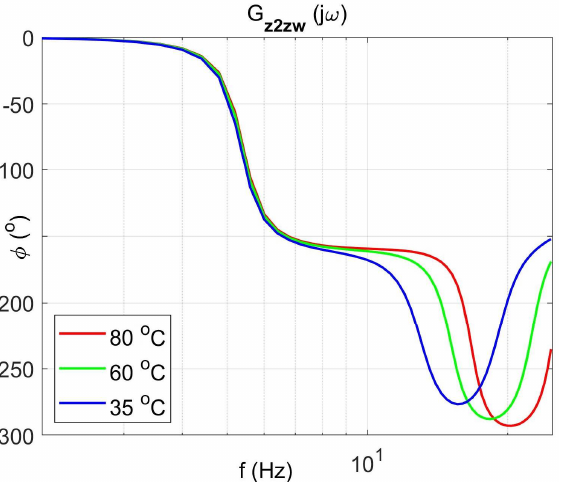
Figure 14. Vibration transmissibility functions of disturbance z w to the absorber mass m 2 as a function of frequency for selected temperatures 25 ◦ C, 60 ◦ C, 80 ◦ C, the transfer function G z 2 zw .